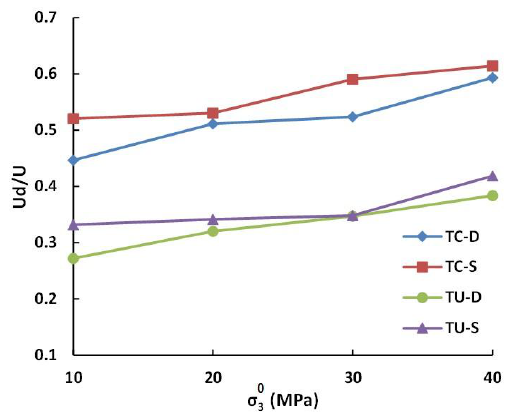
Figure 11. Variation of the U d / U values with the initial confining pressure for dry and saturated sandstone specimens at the critical failure point.